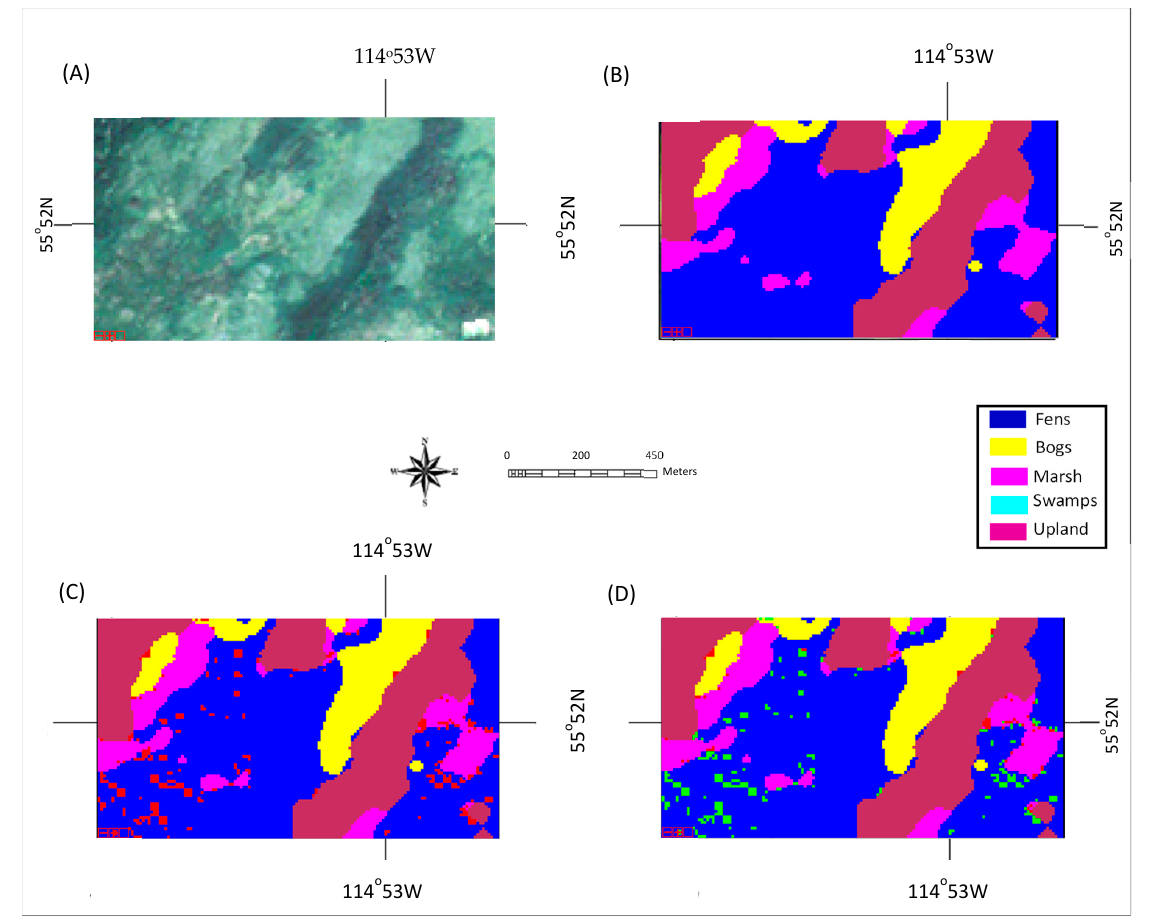
Figure 5. Classification result of a test area dominated by wetland: ( A ) true-color composite of a Sentinel-2 image; ( B ) ground-truth-based classification map; ( C ) classification map using Classifier #1 where misclassified pixels are highlighted in red; ( D ) classification map using Classifier #1, where the misclassified pixels, which were corrected using the proposed method, are highlighted in green.